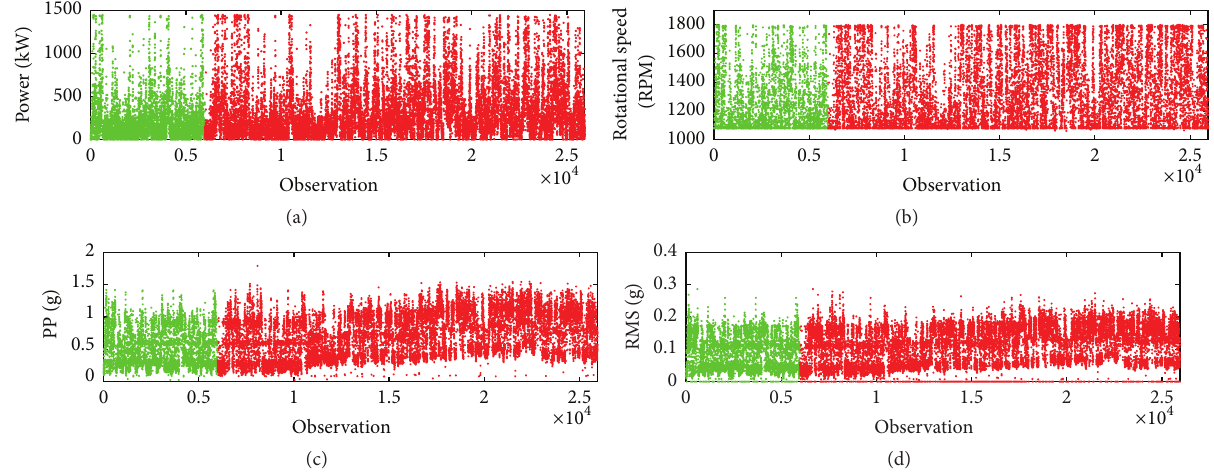
Figure 5: Observed parameters: power output (a), rotational speed (b), PP (c), and RMS of vibration signal from planetary gearbox (d). In green, data used for training; in red, data used for